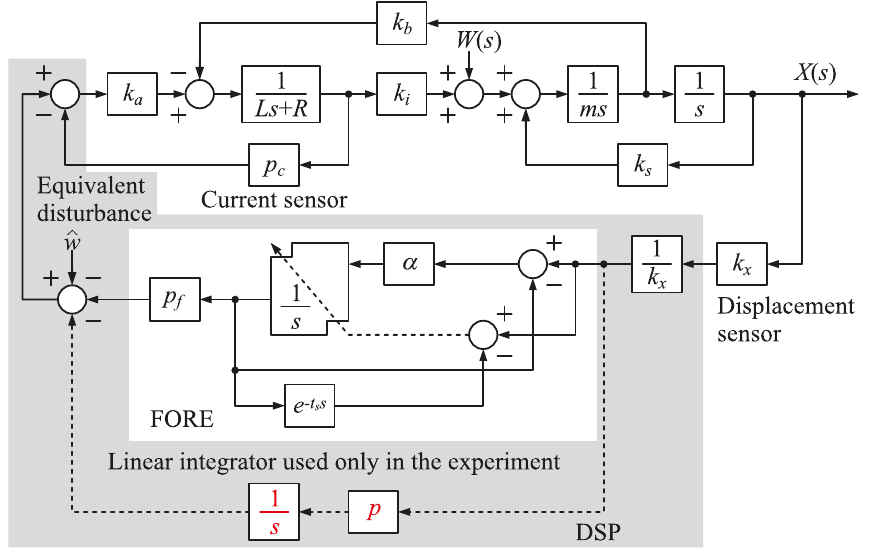
Figure 8. Block diagram of the magnetic suspension control system. The integrator at the bottom was used only in the experiment.